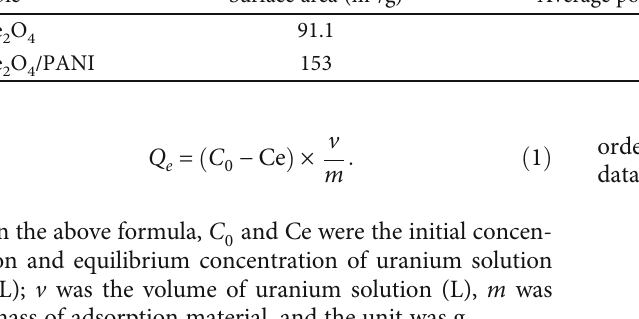
Figure 4: N adsorption-desorption curves of CuFe 2 Table 1: Analysis of speci fi c surface area and pore volume of CuFe Sample Surface area (m 2